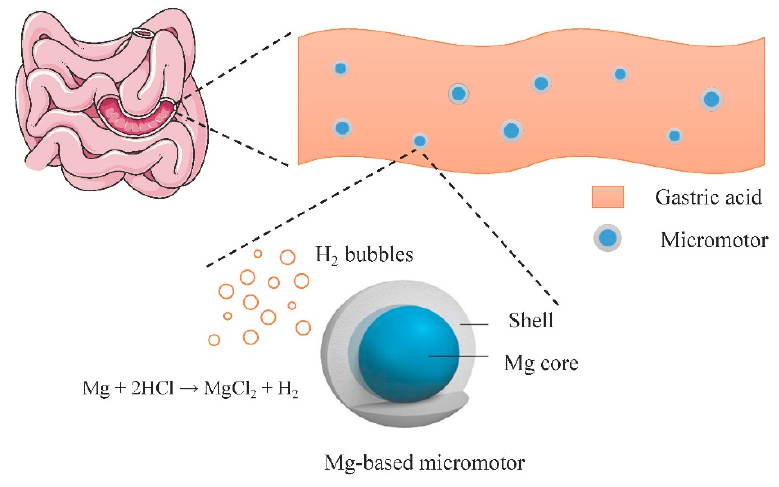
Figure 4. Micromotor body generates hydrogen bubbles to propel the micromotors in the gastric tract.